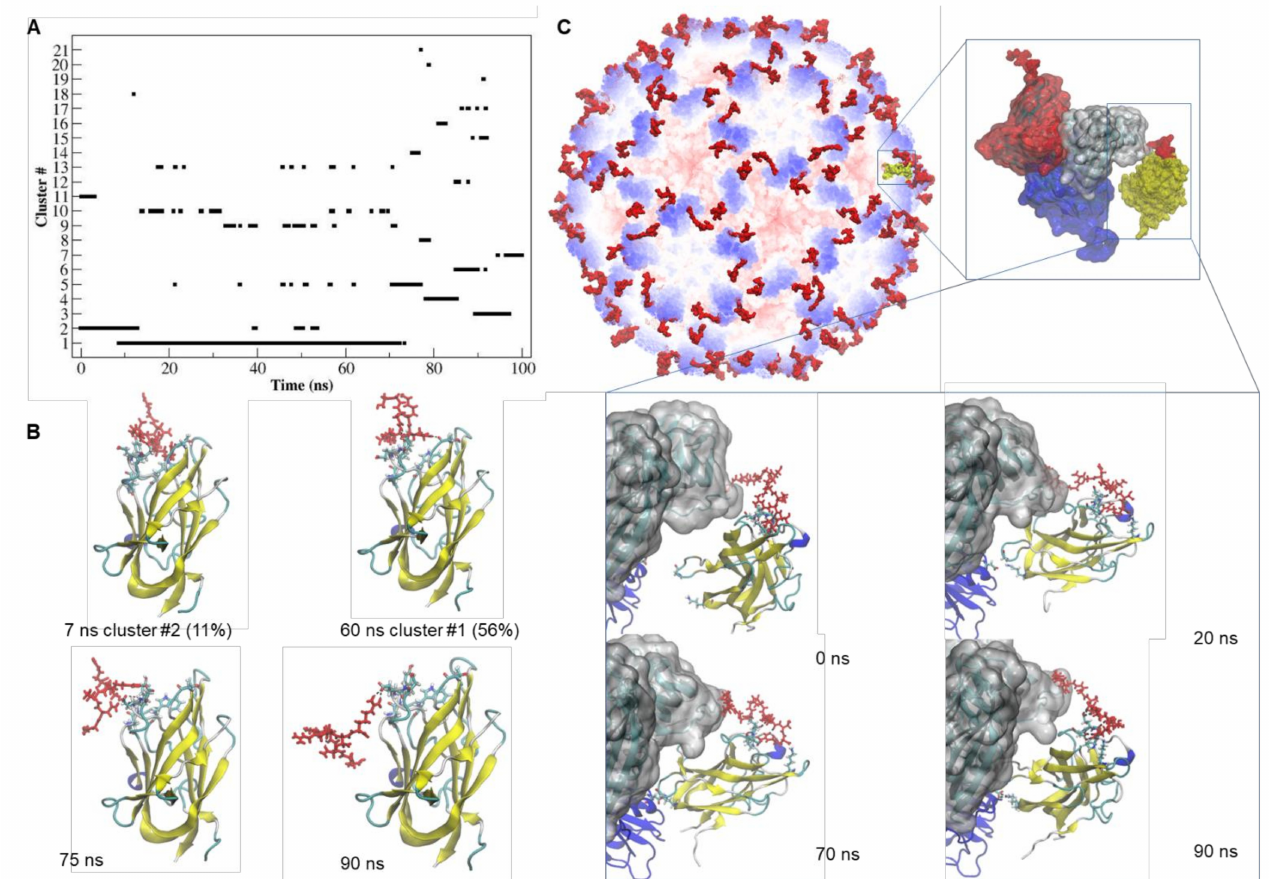
Figure 3. Dynamics and stability of the interaction of tLyp1-NRP-1 and TBSV CPtLyp-NRP-1 . (A) Number of clusters as a function of simulation time and their occupancy throughout the trajectory of the tLyp1-NRP1 complex. ( B ) Simulation snapshots of the tLyp1-NRP1 complex, taken at selected times of the MD trajectory. The residues of NRP-1 involved in the interaction with tLyp1 are represented by licorice model. tLyp1 is colored in red and depicted in licorice model. The representative structures of the most populated clusters and their percentage of occupancy along the trajectory are also indicated. Black dashed lines: hydrogen bonds. ( C ) Structural model of TBSV-tLyp1 in complex with NRP-1. Zoom views: simulation snapshot of the asymmetric unit of the cTBSV docked with NRP-1 receptor (shown in yellow and by Surface representation model) and simulation snapshots of the CPs of the asymmetric unit docked with NRP-1 (shown by New Cartoon representation model) taken at selected times of the MD trajectory. The tLyp1 peptide is depicted in licorice model and colored in